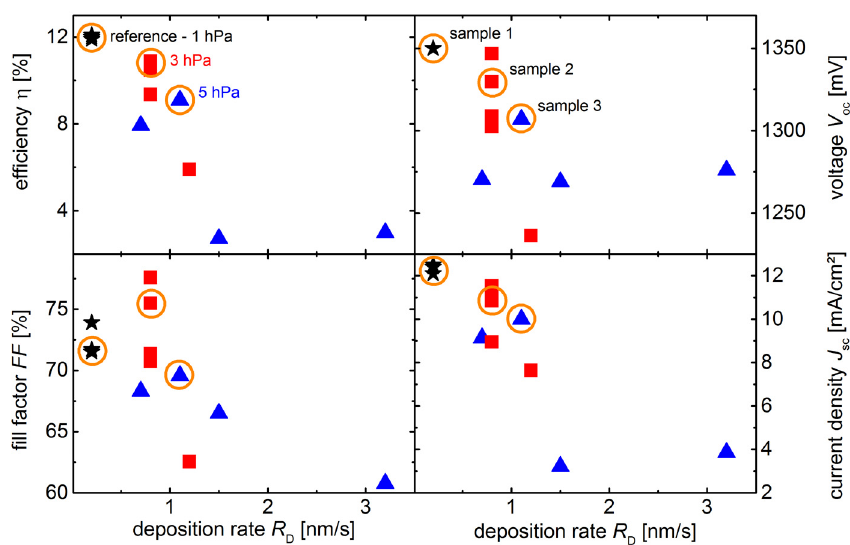
Fig. 1. Photovoltaic-parameters – efficiency η , fill factor FF , open-circuit voltage V oc , and short-circuit current density J sc – as a function of the deposition rate R D . The circles indicate samples 1, 2, and 3, which were further investigated by light induced degradation